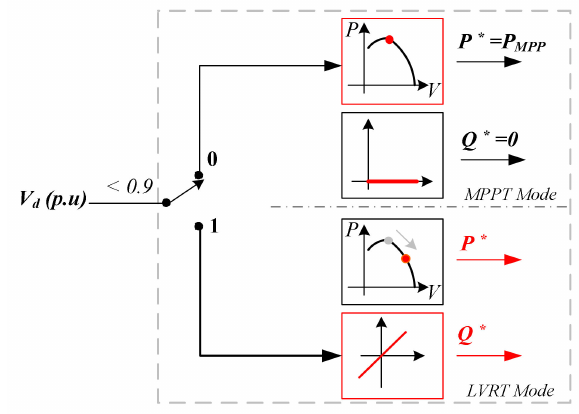
Figure 4. Operation modes of system under